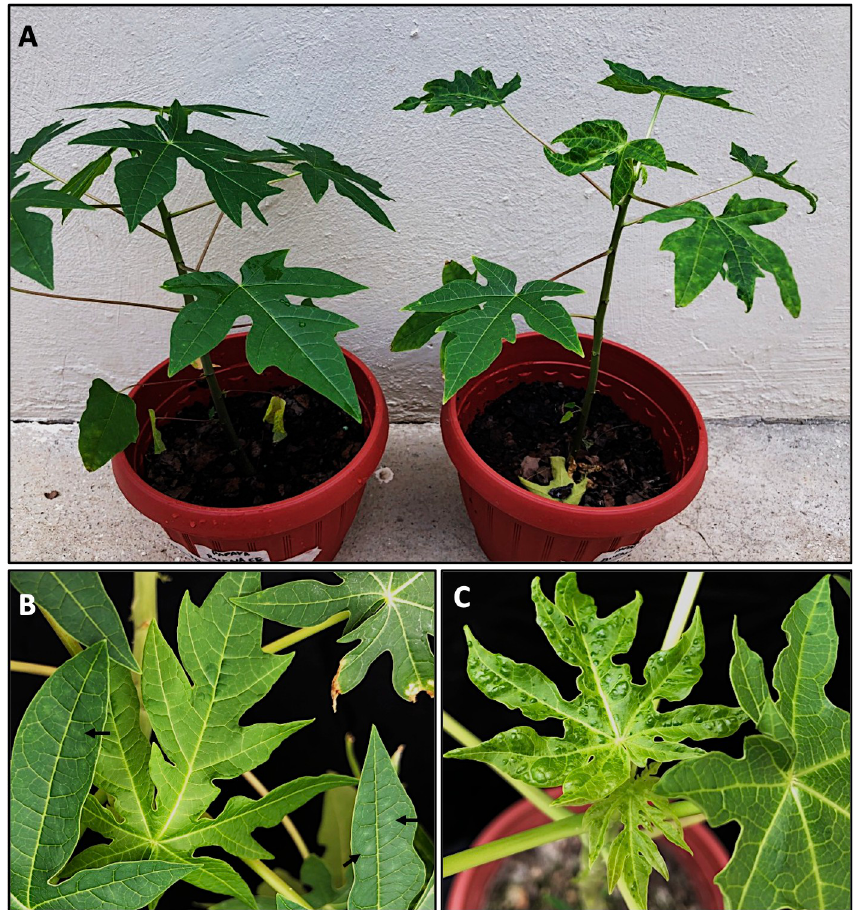
Fig 3. Cross-protection effect of a mild isolate of papaya ringspot virus (PRSV-mild) against a severe isolate (PRSV-sev). A) Overall growth comparison between an immunized (PRSV-mild infected) and a mock-immunized plant at 45 days post superinfection. B) Mild leaf symptoms on immunized plant. Arrows show the mild powder-like patches radiating from secondary veins. C) Severe blistering observed in the mock-immunized plant induced by